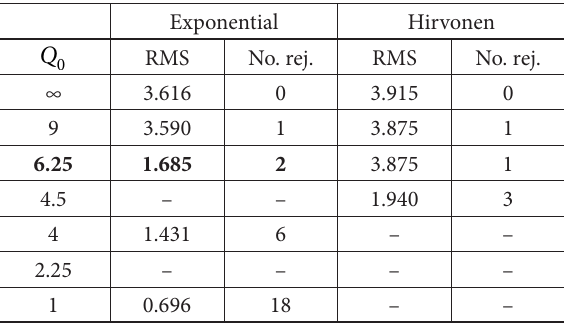
Table 1. Test computation results, c = 0.25. The Root-Mean- Square error of fit and the number of rejected outliers according to 3σ test criterion are listed Exponential Hirvonen